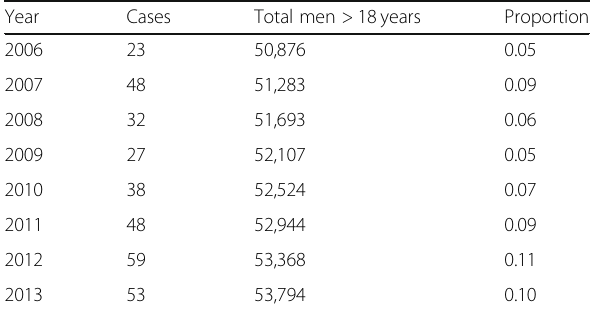
Table 3 Proportion of men ≥ 18 years with hydrocoele by year